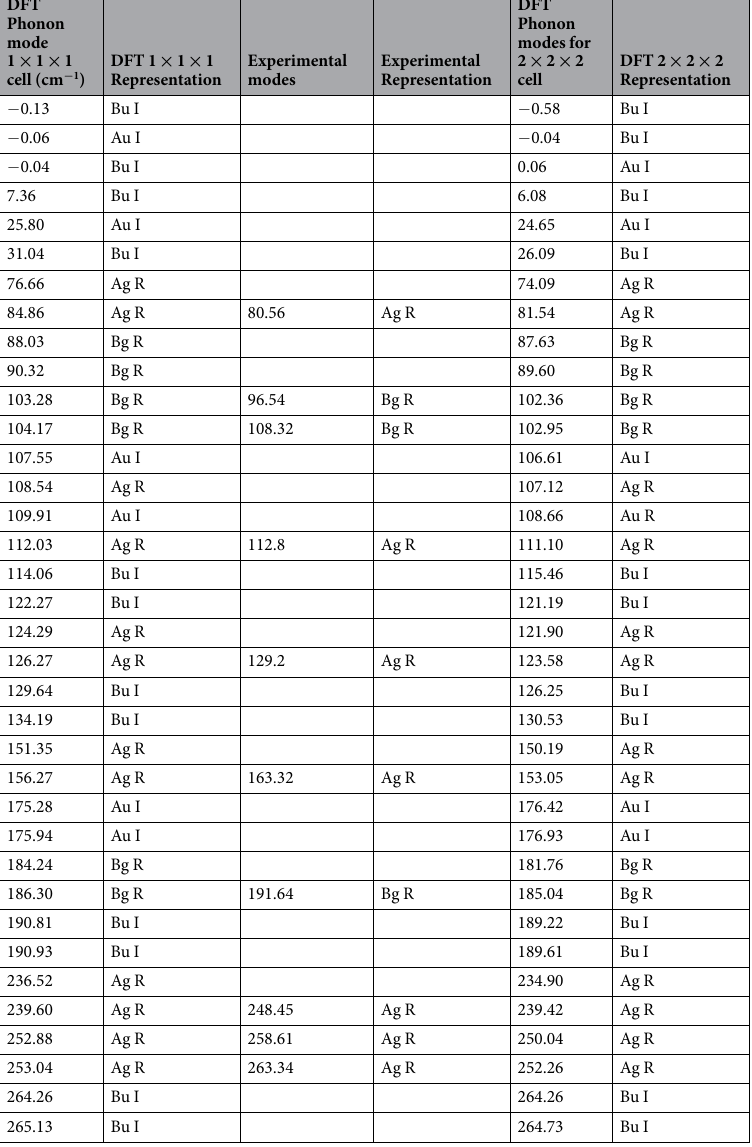
Table 3. Phonon modes for 1T’ MoTe 2 for 1 × 1 × 1 conventional cell, 2 × 2 × 2 conventional cell with optB88 functional and polarization-resolved Raman experiment. Representation table of modes are also shown. I, and R stands for infrared and Raman active modes